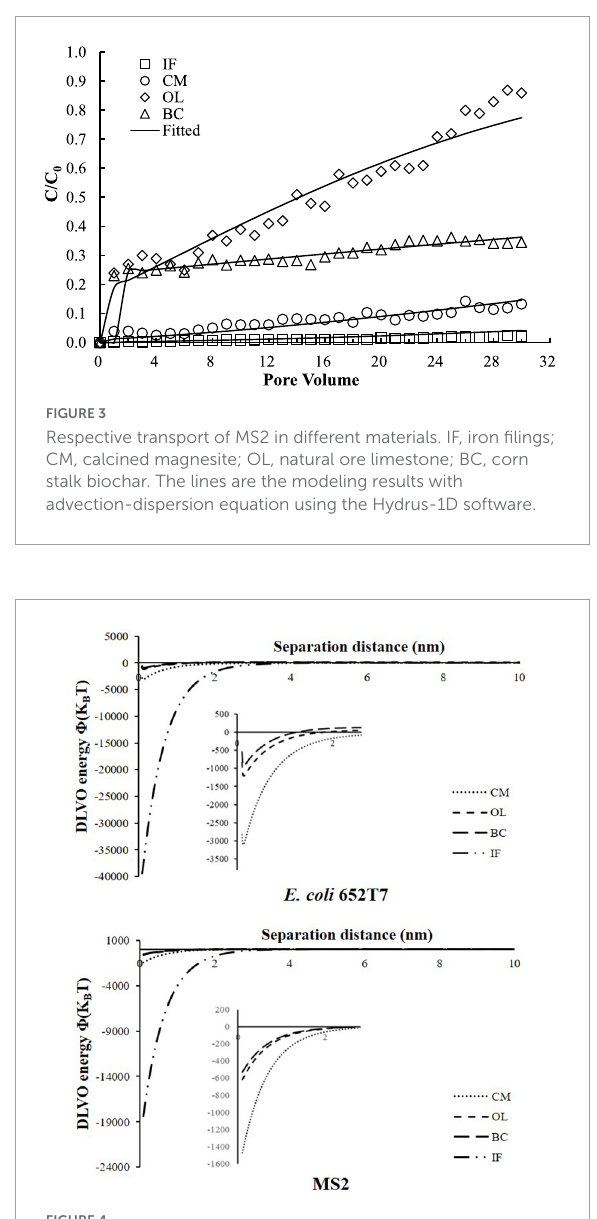
FIGURE4 Predicted potential energy profiles of (cid:56) XDLVO for microbial particles material surfaces as a function of the separation distance. IF, iron filings; CM, calcined magnesite; OL, natural ore limestone; BC, corn stalk